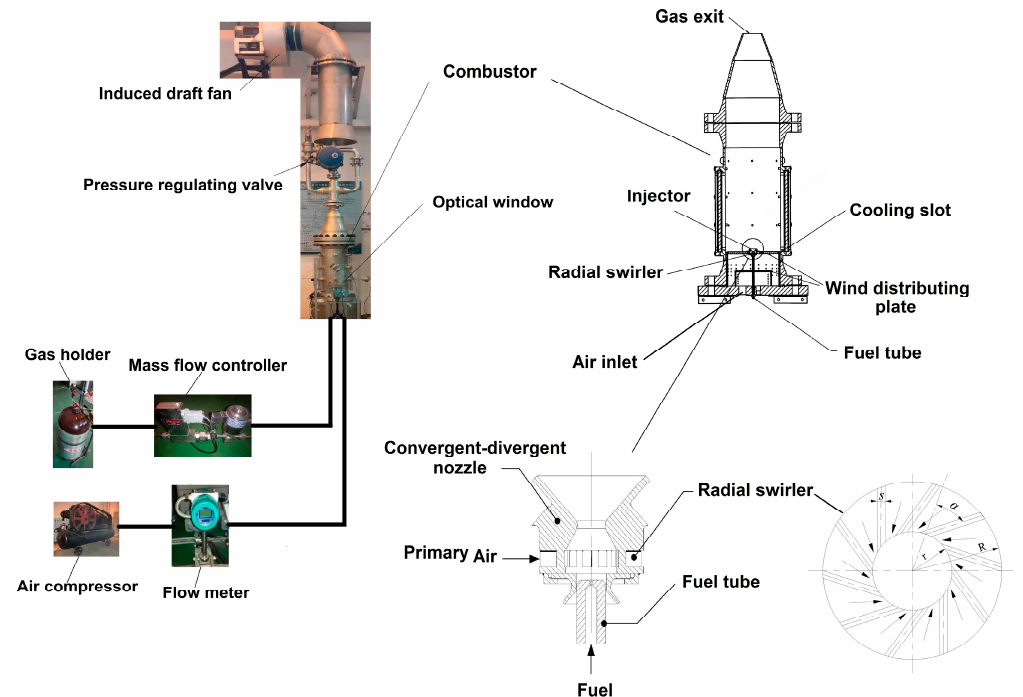
Figure 1. The layout of the combustion device.